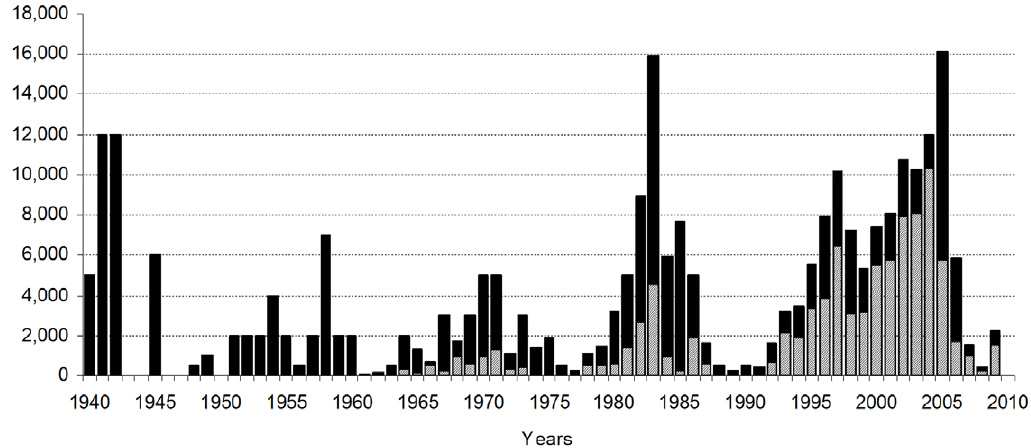
Figure 1. Adult Chinook salmon population trend. Stacked bar graph of the total number of adult fall-run Chinook salmon ( Oncorhynchus tshawytscha ) spawning on the Mokelumne River (black bars), and in the Mokelumne River Fish Hatchery (grey bars) from 1940–2009 (East Bay Municipal Utility District, unpublished data). Graph shows adult spawning location and not rearing origin. Note: Mokelumne River Fish Hatchery was built in